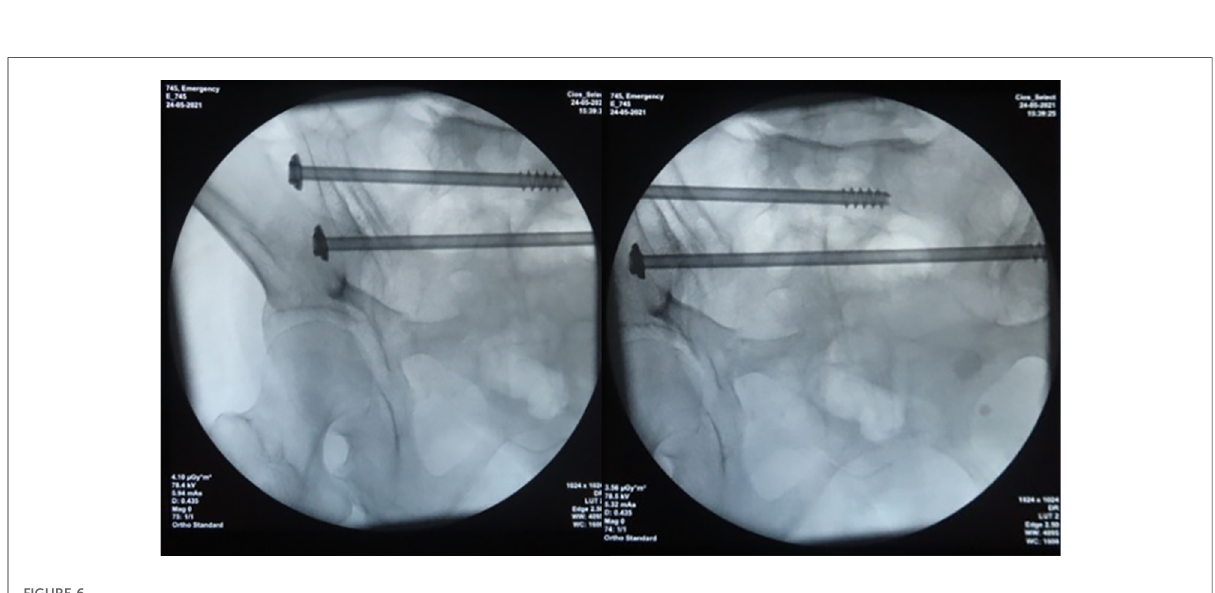
FIGURE 6 Radiographic imaging with C-arm.